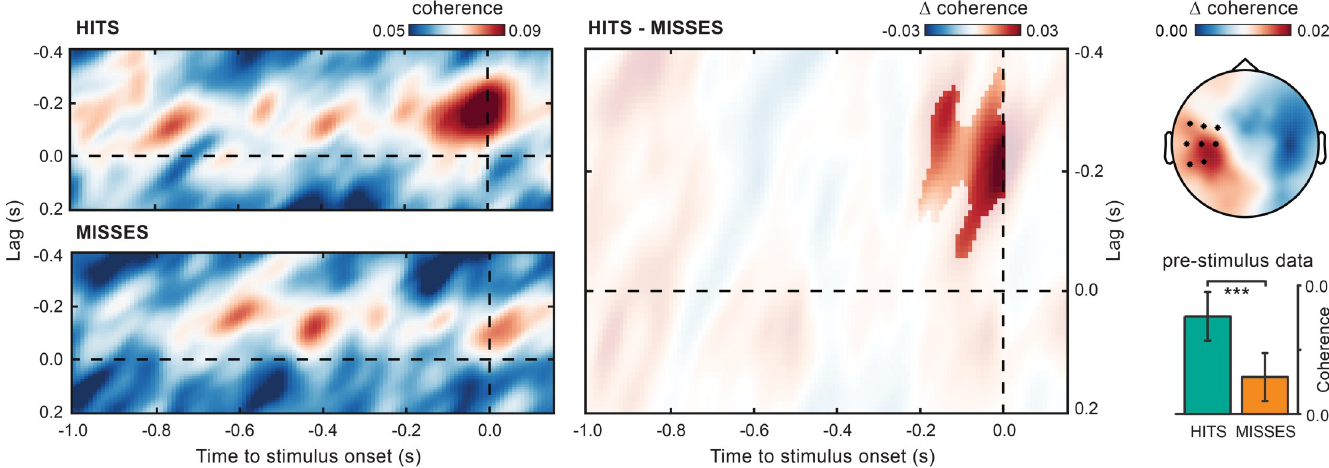
Fig 6. Cortico-force alpha coherence just before stimulus onset predicts perception. Lag- and time-resolved cortico-force alpha (10.5 Hz) coherence over the prestimulus period for hits, misses, and their difference (hits–misses). The highlighted area indicates the time and lag intervals belonging to the cluster that survived cluster-based permutation statistics for the hits–misses contrast. Alpha coherence is averaged over the EEG electrodes belonging to the same cluster (evaluated at time 0 seconds and lag − 0.2 seconds; see black asterisks in the topographic map). The topography shows the hits–misses difference in alpha coherence averaged over the time and lag intervals belonging to the same cluster. The bar plot shows alpha coherence for the electrode CP5, calculated at lag − 0.2 seconds and time − 0.16 seconds, i.e., the time point closest to stimulus onset in which the analyzed data windows do not include any poststimulus data point. Error bars indicate ± 1 SEM. ��� p < 0.001. For the underlying data, see https://osf.io/VSZCB/. EEG, electroencephalography.